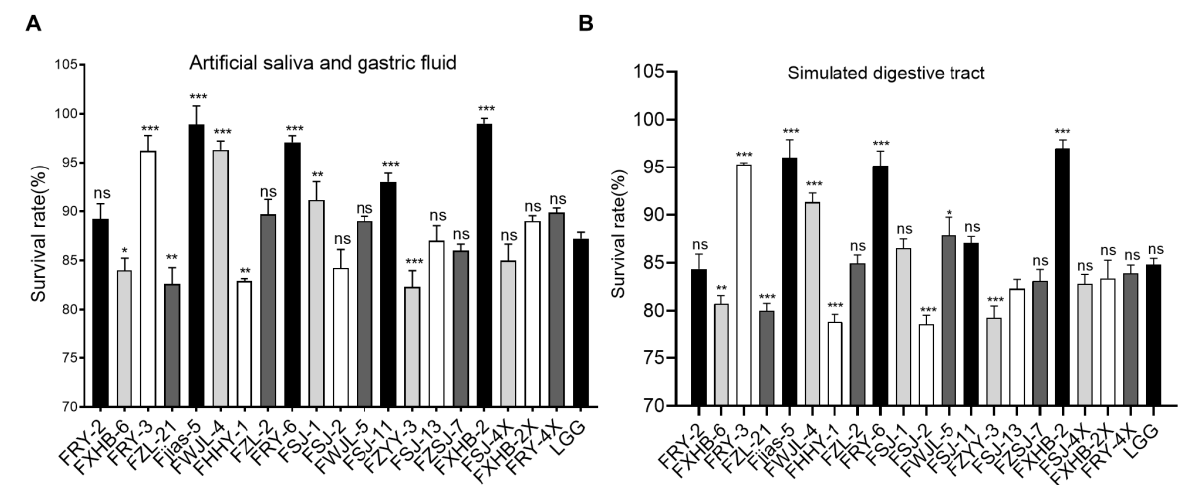
Figure 2. The survival rates of the selected strains in simulated digestive tract conditions. All data were expressed as mean ± SD ( n = 3 independent experiments). Statistical significance was defined as * p < 0.05; ** p < 0.01; *** p < 0.001. “ns”: no significance. ( A ) Differences of selected strains in artificial salvia and gastric fluid compared with reference strain LGG. ( B ) Differences of selected strains in simulated digestive tract compared with LGG.